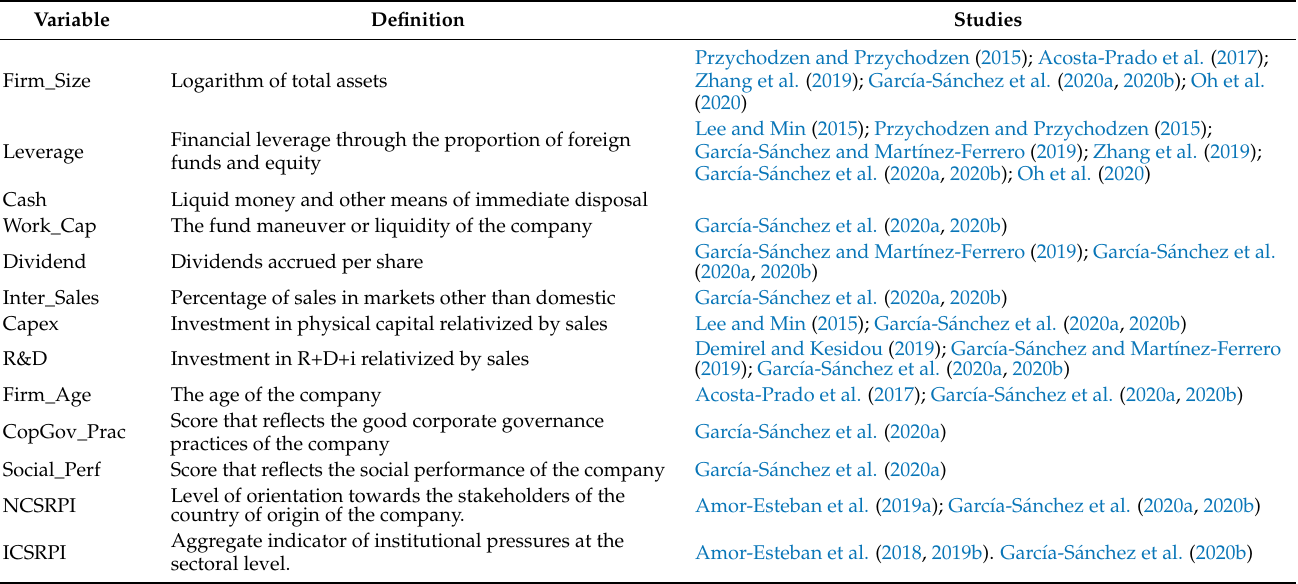
Table 1. Control variables